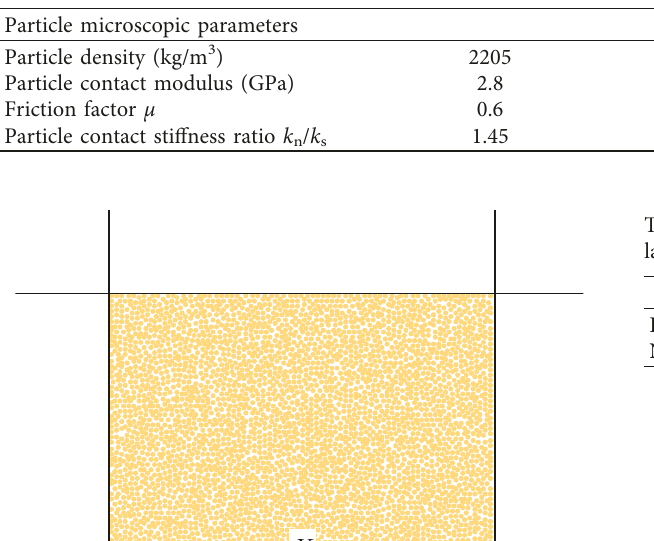
Table 1: Mesoscopic parameters.